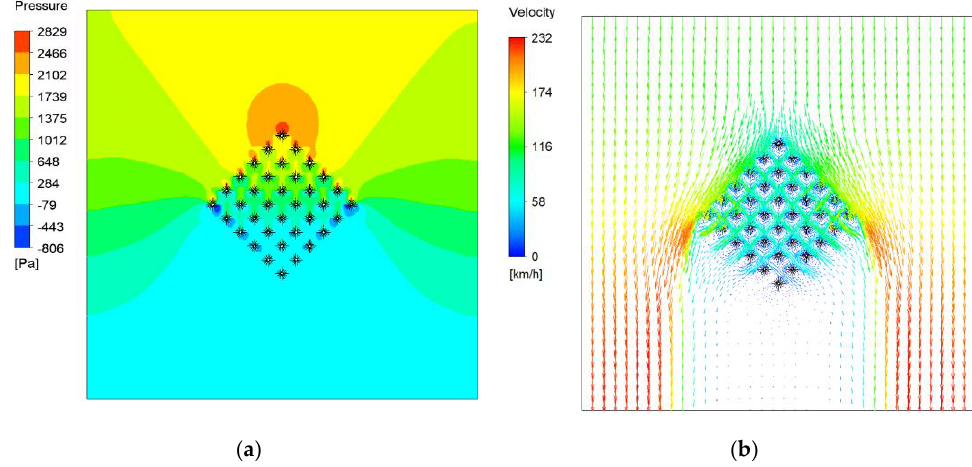
Figure 10. ( a ) Pressure distribution, ( b ) Velocity distribution (s = 350 mm, v inlet = 120 km/h, α = 45 ◦ ).